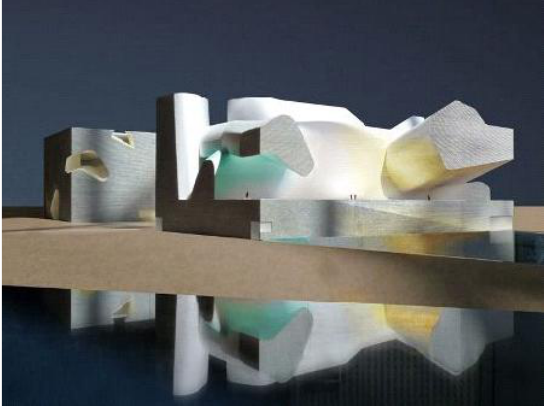
Fig. 10: Ying-Yang museum (3D). (Phaidon, 2016)